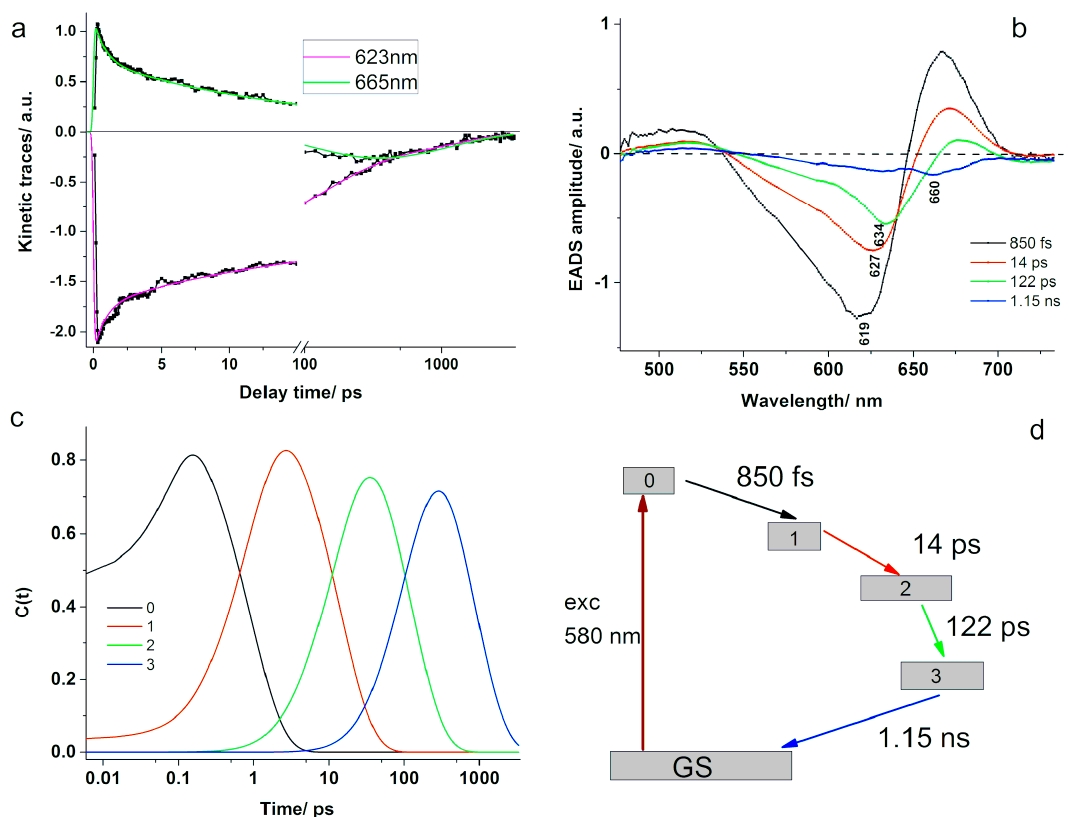
Figure 9. ( a ) Kinetic traces recorded at 623 and 665 nm with fits; ( b ) Global analysis of the absorption changes induced in the PBS after 580 nm excitation showing the resulted evolution-associated difference spectra; ( c ) time dependencies of the populations of different compartments; ( d ) the kinetic scheme used for the global analysis model. GS—ground state, 0 and 1—the sensitizing and respectively fluorescing chromophores in phycocyanin, 2—phycocyanin rods, and 3—allophycocyanin.